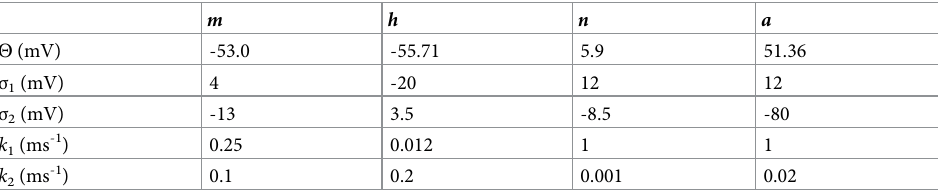
Table 1. Parameters for gating variables. The θ parameters are given for the homogeneous network in Fig 4. These parameters were varied across the network in order to reproduce the variability in f/I curves. The other parameters were held constant for all model